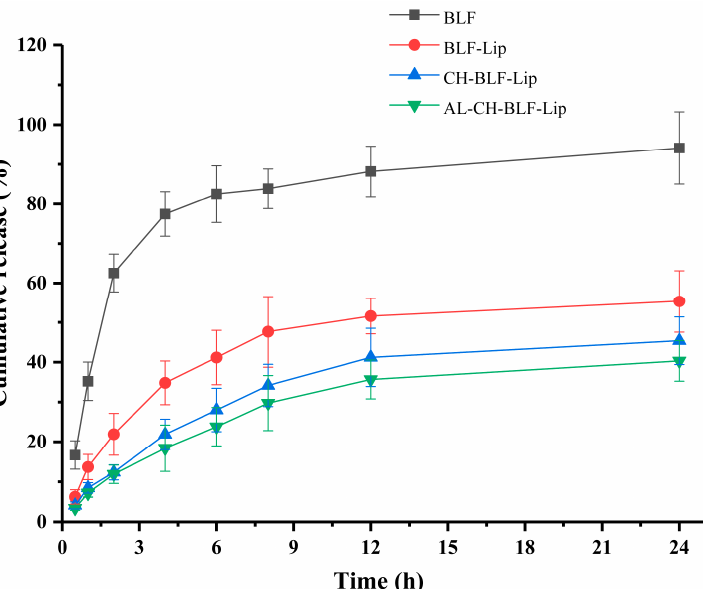
Figure 5. In vitro release behavior of naked BLF and BLF releasing from different BLF-loaded nanoliposomes. Data were presented as mean ± SD of three independent replications. BLF, bamboo leaf flavonoids; BLF-Lip, BLF-loaded nanoliposomes; CH-BLF-Lip, BLF-loaded chitosan coated nanoliposomes; AL-CH-BLF-Lip, BLF-loaded alginate-chitosan coated nanoliposomes.